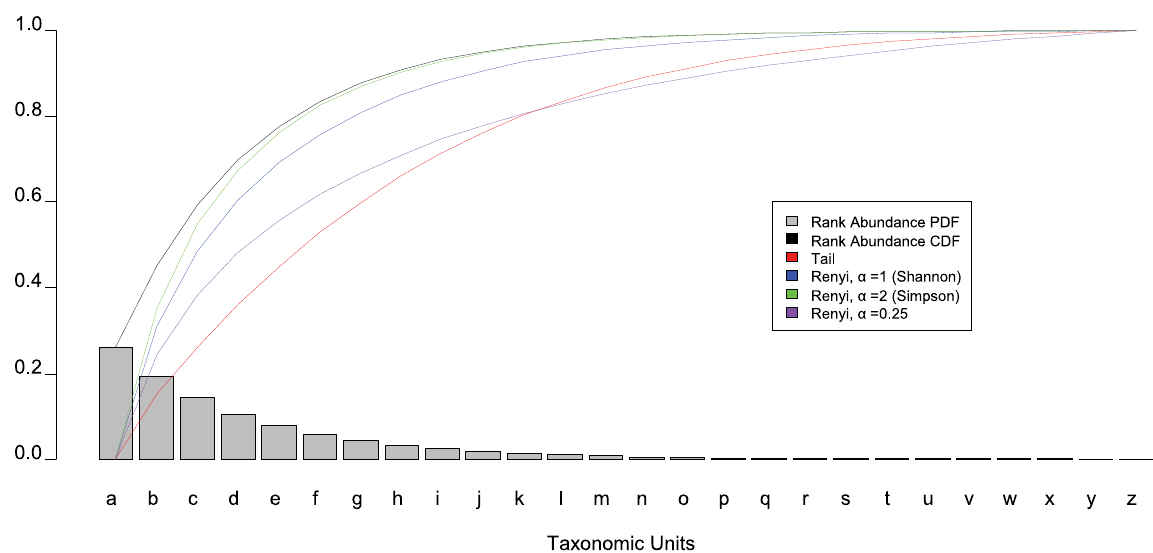
Figure 1. Contribution of taxa to diversity. A theoretical rank abundance curve (a PDF) is overlayed with its CDF (black) as a ‘‘Pareto chart’’. The overlaid colored lines represent each diversity index as lower abundant taxonomic units are included. For example at ‘‘c’’, the height of each curve represents the relative value of the index if the sample were only composed of a, b, and c. The more quickly an index curve reaches it maximum normalized value of 1.0, the less the index is capable of resolving low abundance taxonomic units. From the graph, it can be observed that the Shannon and Simpson diversity indices approach their saturation point more quickly than the Tail statistic or a Renyi entropy with a fractional alpha.